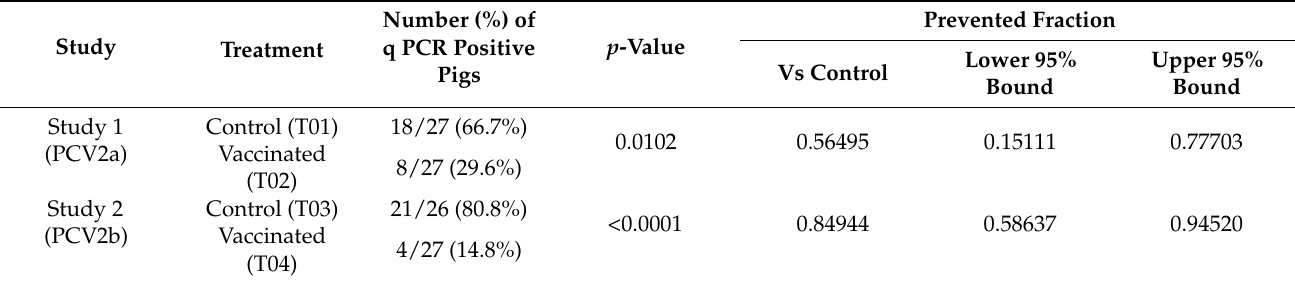
Table 3. Percent of ever positive pigs and estimate of prevented fraction for PCV2 fecal